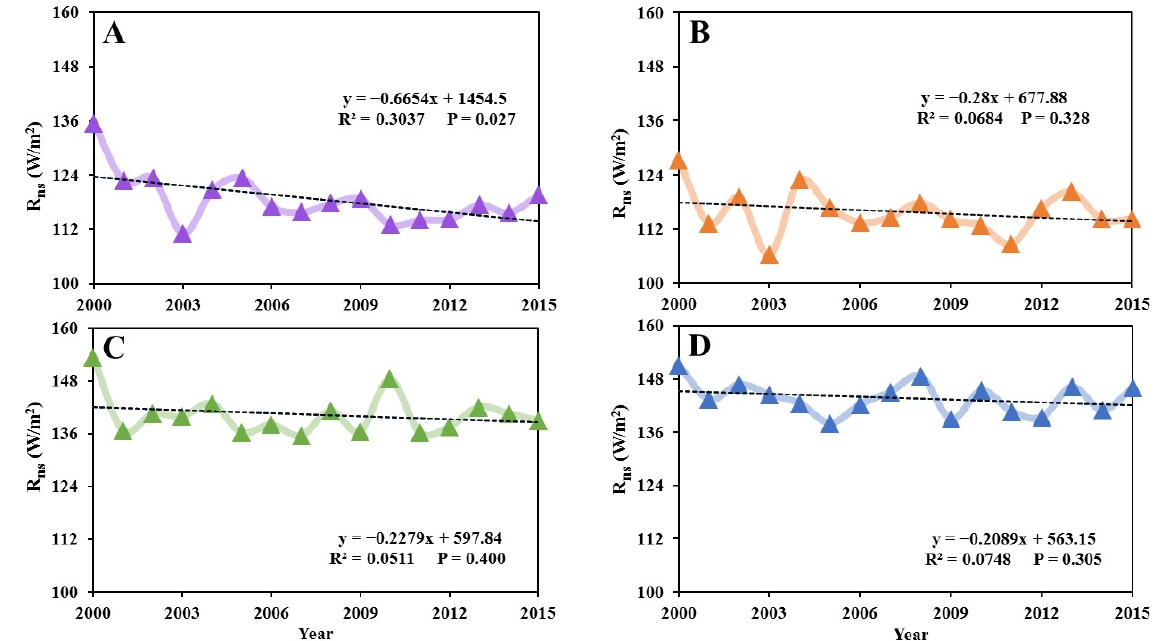
Figure 10. Trend of shortwave radiation from 2000 to 2015 ( A ): Jinan City, ( B ): Zhengzhou City, ( C ): Lanzhou City, ( D ): Xining City).